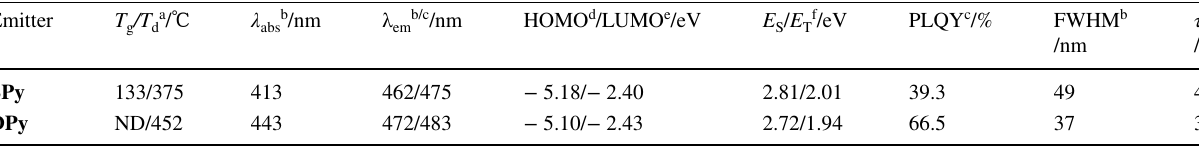
b Measured in dilute T g was measured by DSC. ND stands for not detected.